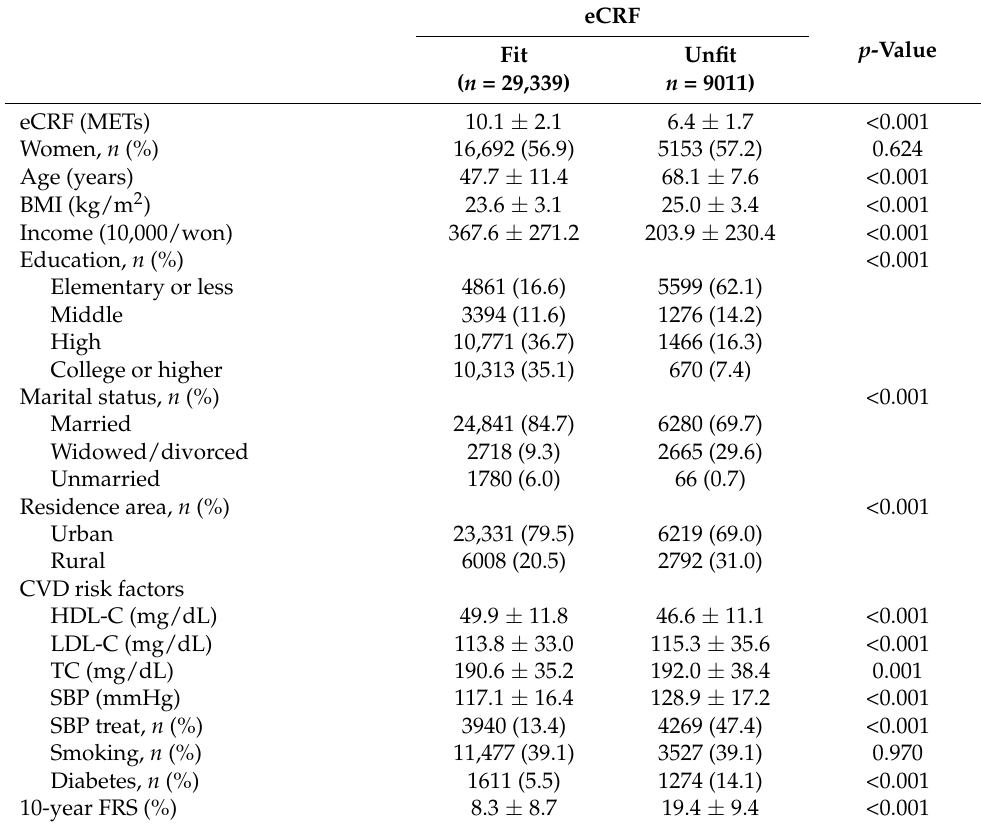
Table 2. Demographics of participants stratified by estimated cardiorespiratory fitness